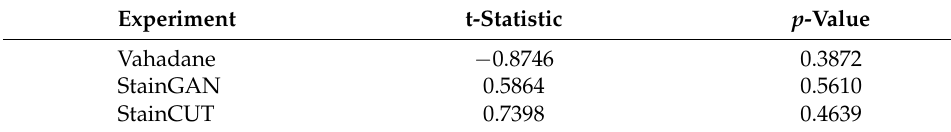
Table A12. Paired t -test to compare Setting (1) to Setting (2) in center RUMC. Experiment